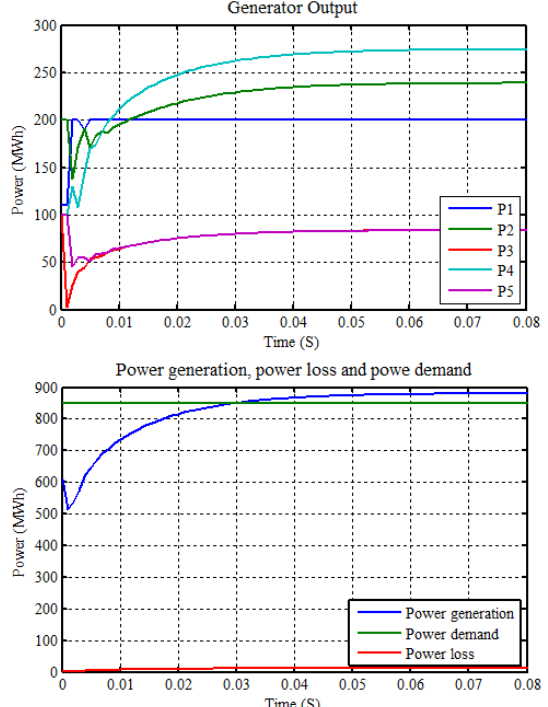
Figure 9. Case study 3: the power generation, power loss and power demand.